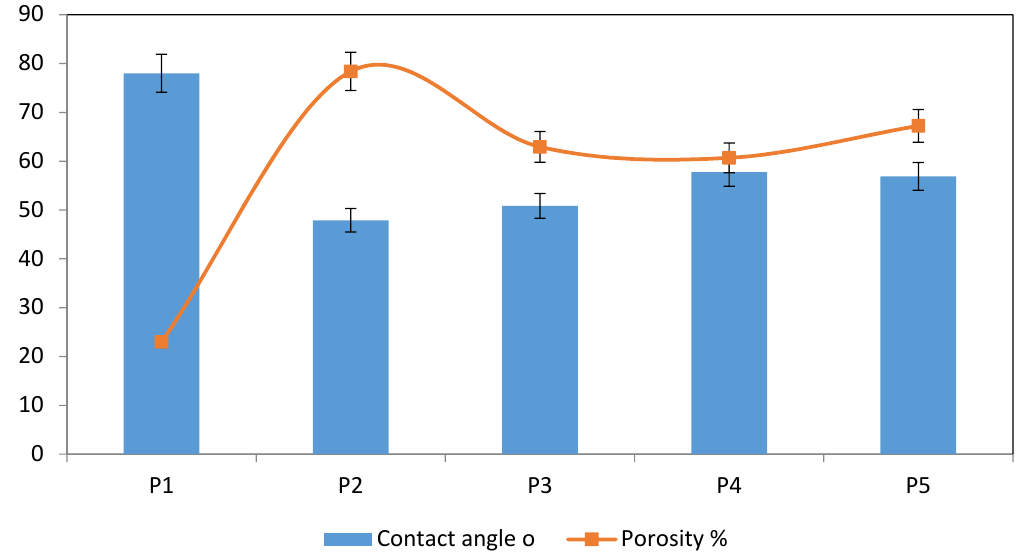
Figure 6. Effect of PES content in PPSU dope solution on porosity and contact angle (CA) of the membranes.